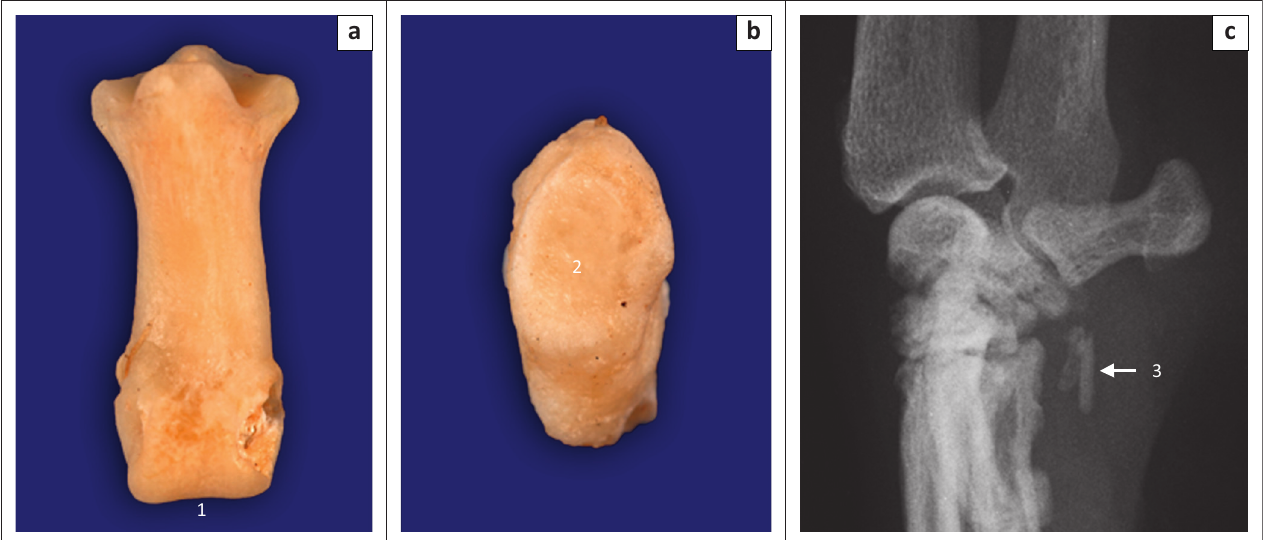
FIGURE 10: (a) Dorsal and (b) lateral views of bone specimens of the middle phalanx and sesamoid bone for the abductor digiti I longus, respectively, of an adult red panda. (c) Mediolateral radiograph of the right carpus of an 11.3-year-old male red